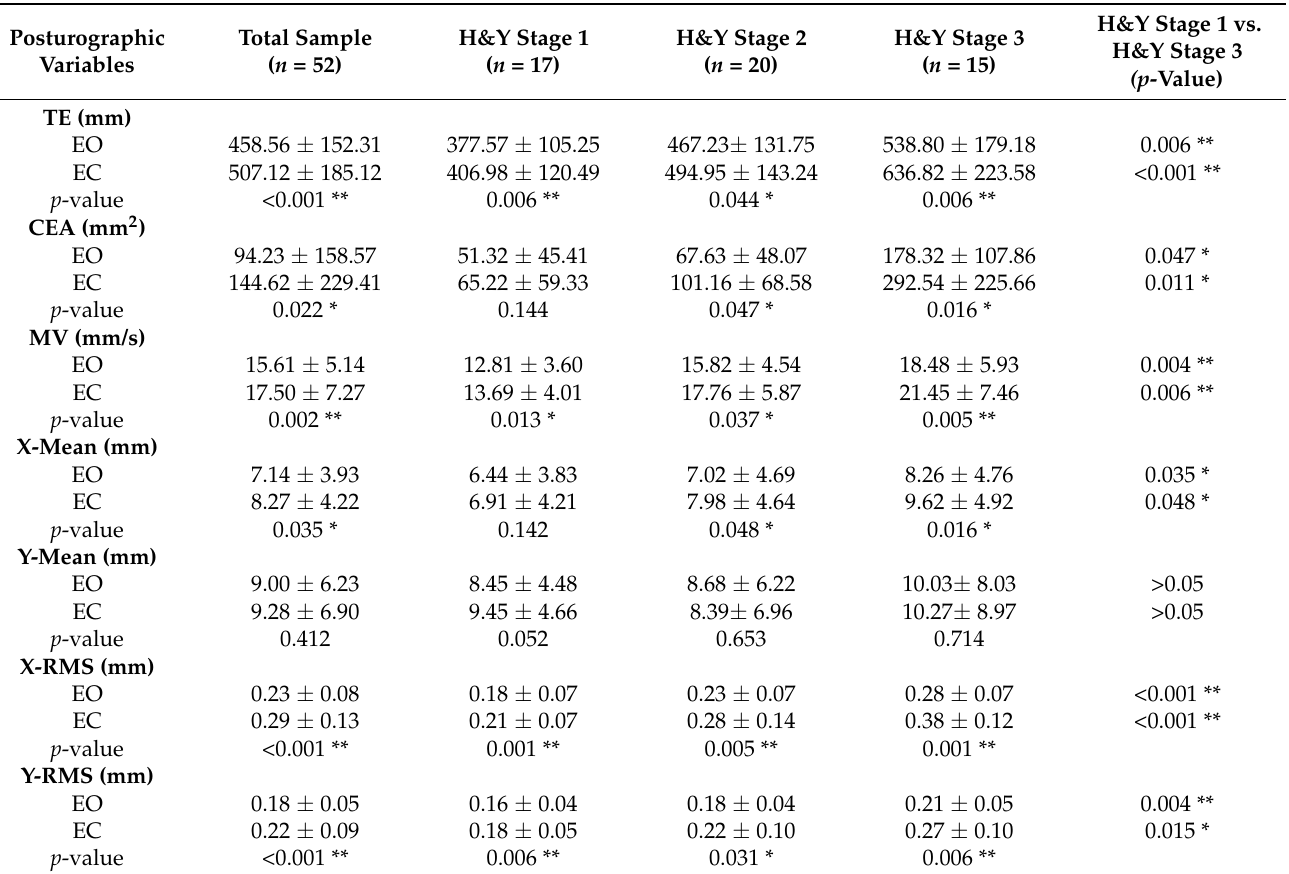
Table 3. Descriptive data of posturographic variables. Differences between disease stages and visual conditions.